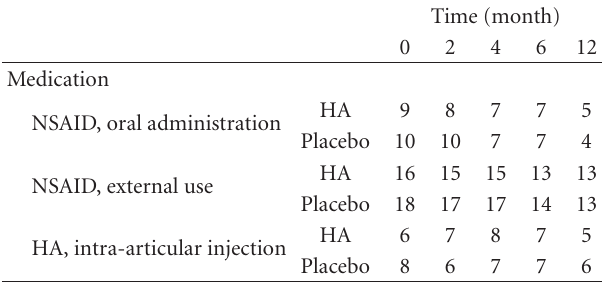
Table 4: Use of additional